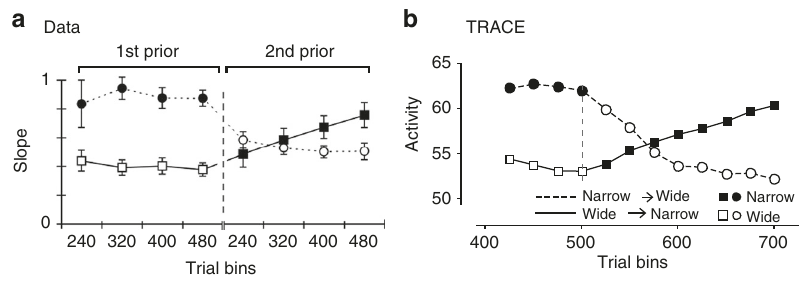
Fig. 5 Comparison of TRACE with human behavior during learning. a Human behavior during transitions between a wide and narrow prior distribution in a time interval reproduction task similar to RSG. The data are adapted from previous work 2 . The results were quanti fi ed by a previously reported ‘ slope ’ parameter that quanti fi ed the strength of the bias towards the mean of the prior (in this case, higher slope represents more bias toward the prior). The switch (vertical dashed line) from narrow ( fi lled symbols) to wide (open symbols) decreases the in fl uence of the prior and vice versa. b The corresponding prediction from TRACE (Methods section) indicates the expected timescales during the course of learning such priors. The change in PC activity compared to baseline is plotted on the ordinate (in arbitrary units). TRACE parameters were the same as those used in RSG and were not fi t to the